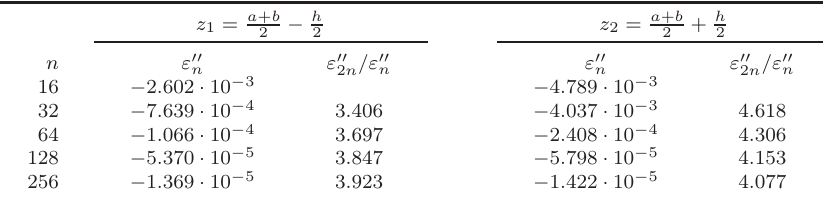
Table 3. Numerical results for y ( x ) = x − 2 , ε ′′ n = S ′′ ( z i ) − y ′′ ( z i ) , i = 1 , 2 . z 1 = a + b 2 − h